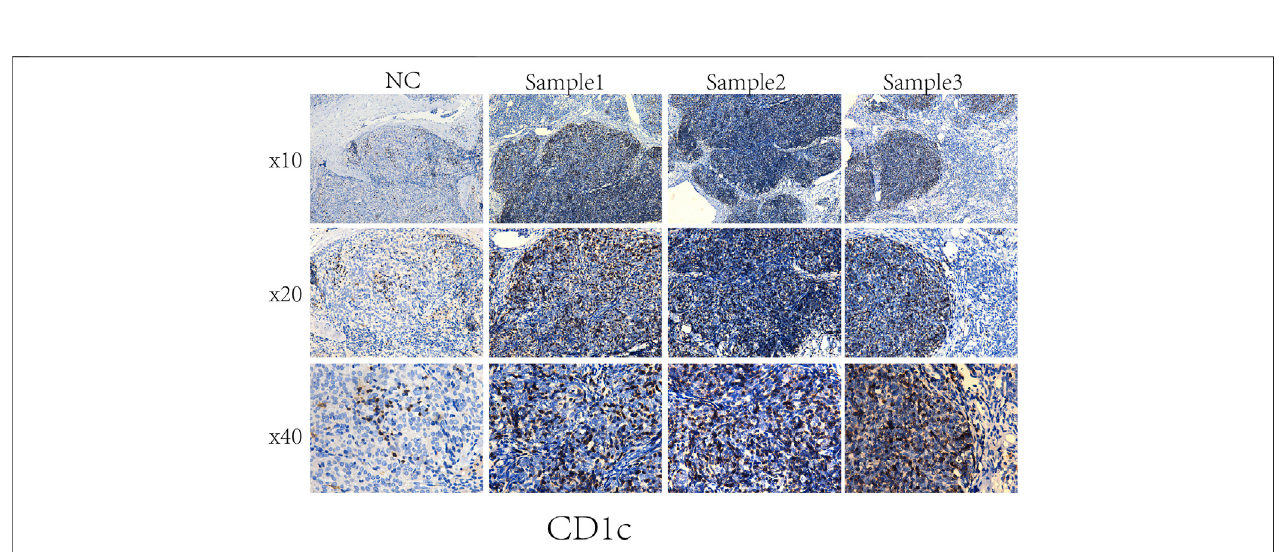
FIGURE10| RepresentativeresultsofimmunohistochemistryshowtheexpressionofCD1CinTHYM andnormaltissues.Originalmagni fi cation: ×200. (A) :CD1C immunostaining of THYM, (B) : CD1C immunostaining of normal tissues.